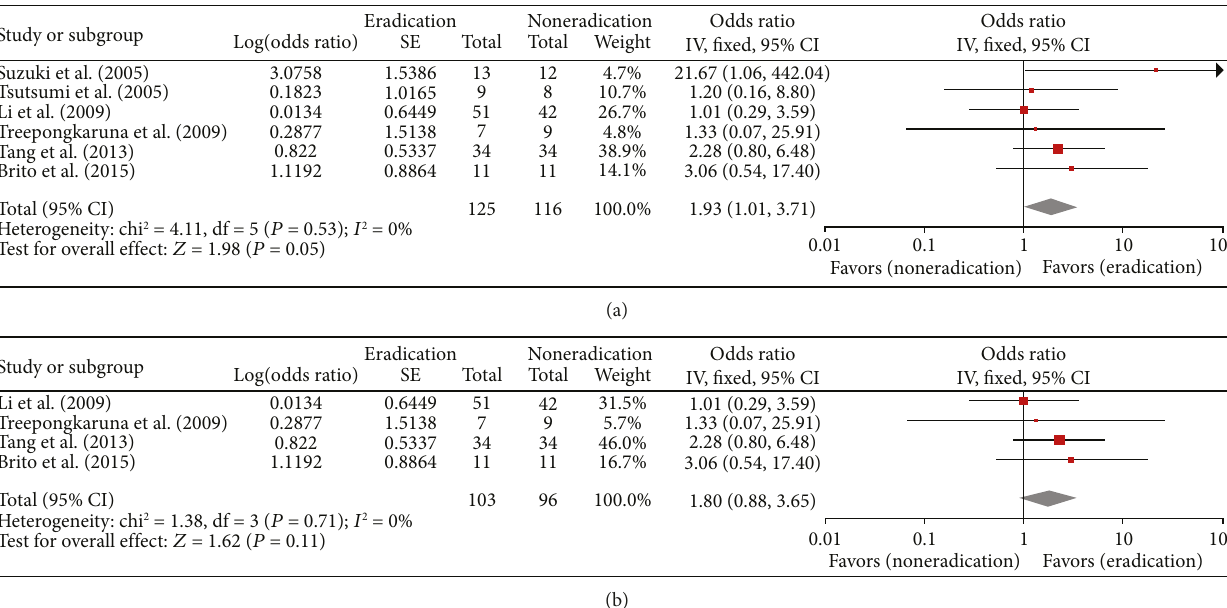
Figure 2: Forest plots of odds ratios for overall platelet response rates in all patients (a) and in children (b).